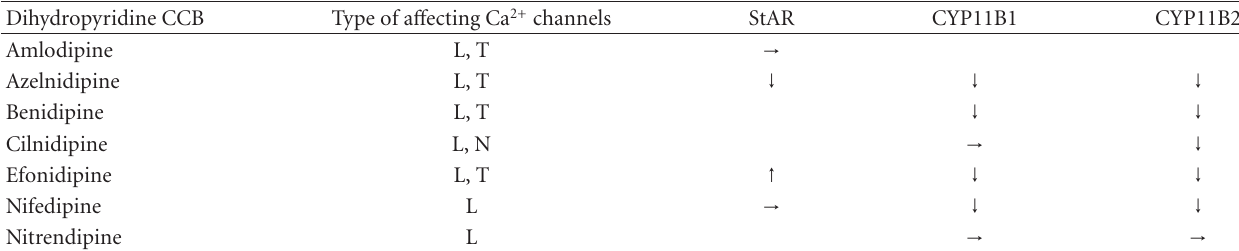
Table 2: The e ff ects of dihydropyridine CCBs on angiotensin II-induced expression of steroidogenic enzymes. Dihydropyridine CCB Type of a ff ecting Ca 2+ channels